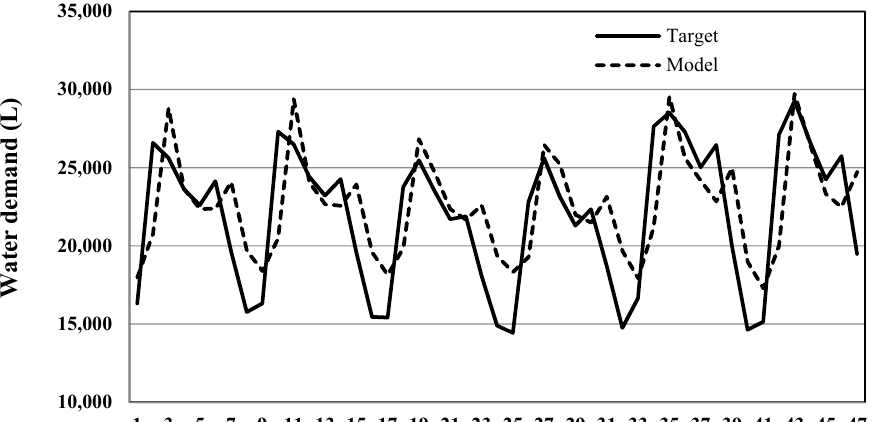
Figure A2. Target vs Model in testing period for the selected Figure A1. Target vs Model in testing period for the selected model. Figure A1. Target vs Model in testing period for the selected model.